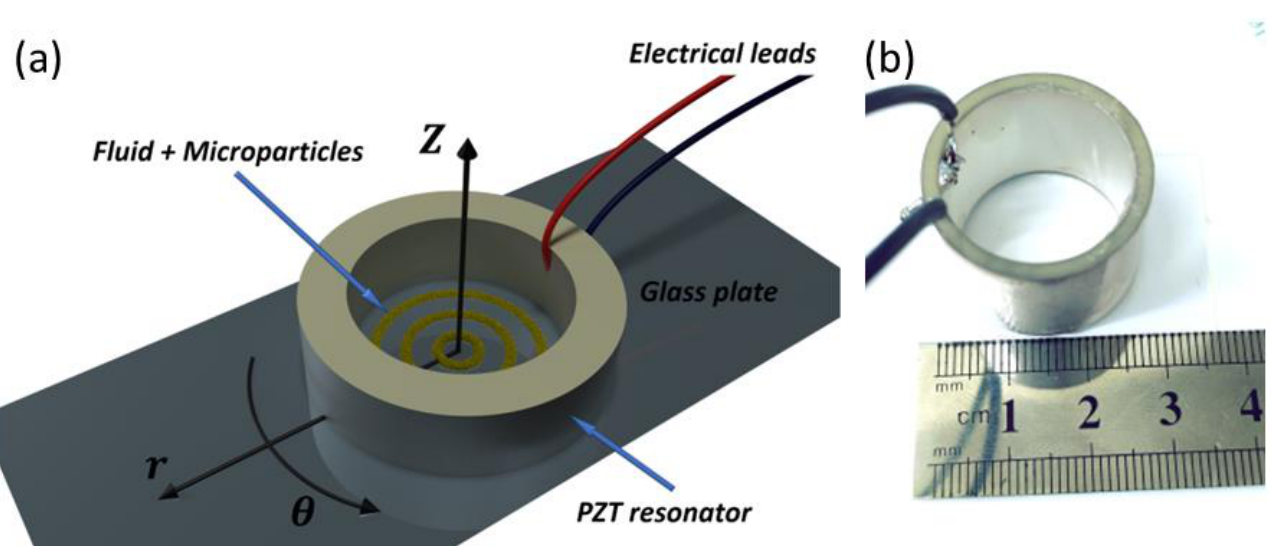
Figure 2. ( a ) Illustration (not to scale) of the experimental in vitro apparatus. The dispersed micro particles are inserted into the piezoelectric resonator. They are driven towards nodal areas and form rings upon activation of the acoustic waves. ( b ) Photograph of the in vitro apparatus.